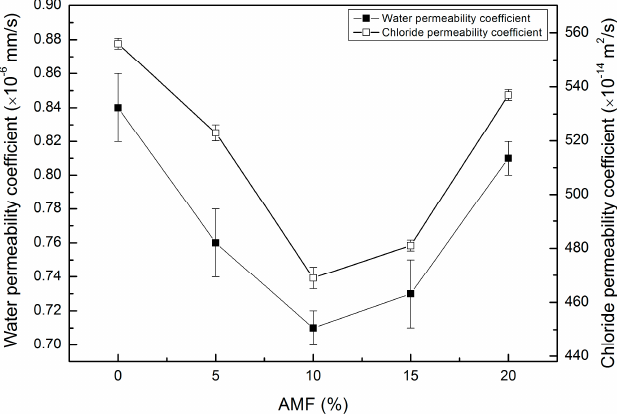
Figure 4. Effect of AMF content on the permeability of concrete. Figure 4. E ff ect of AMF content on the permeability of